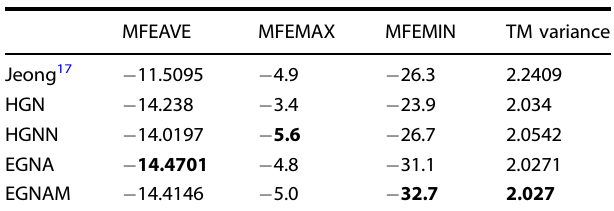
Fig. 5 Gibson assembles address bits and data bits. Table 2. Comparison of single-strand MFE and